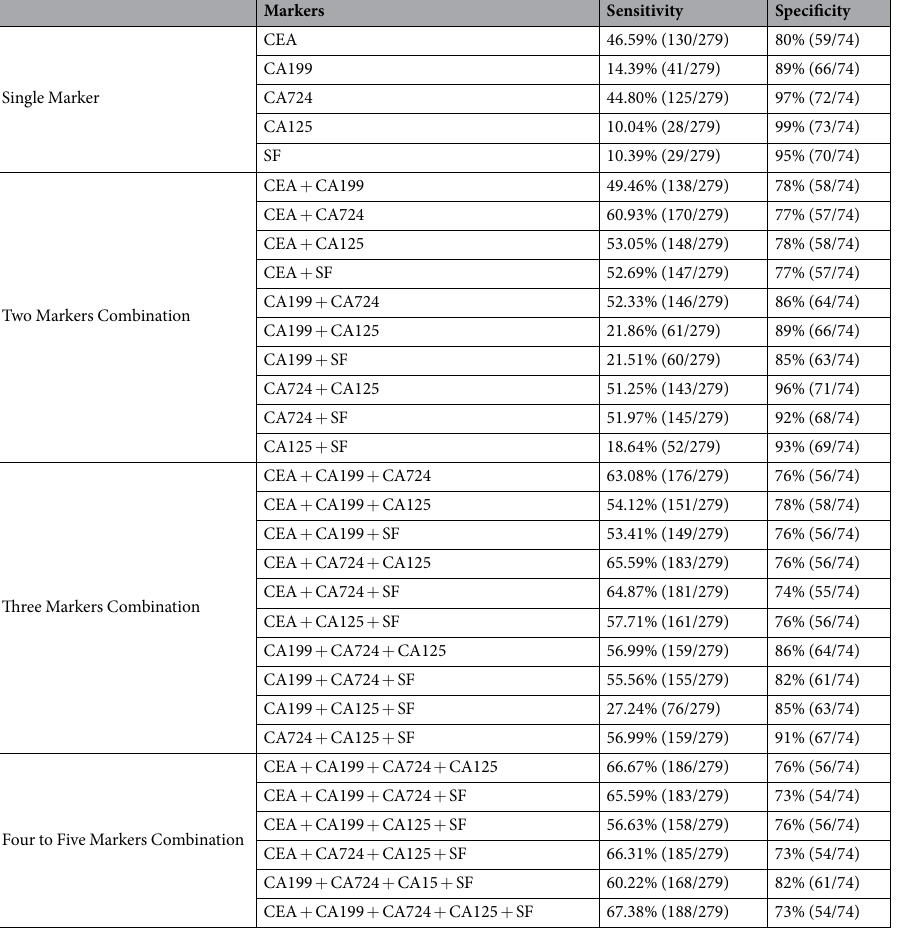
Table 1. The sensitivity of individual and combinational examination of serum biomarkers in CRC